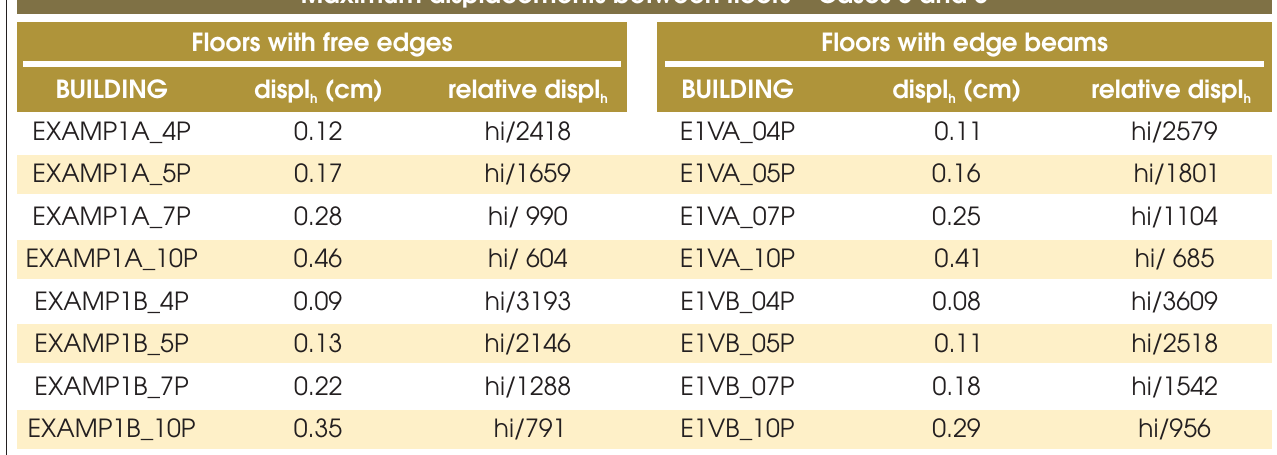
Table 10 – Values of maximum displacements between floors, in cm (cases 5 and